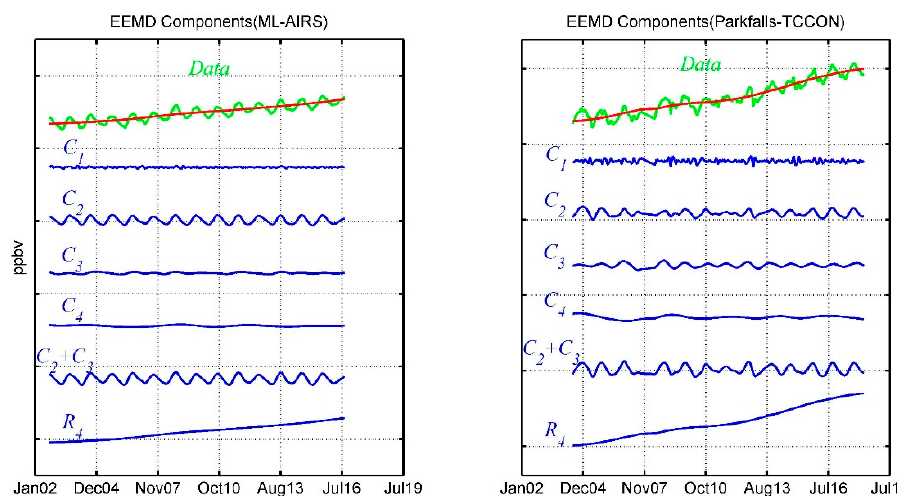
Figure 4. Same as Figure 3, however using AIRS CH 4 over the Mid-latitude region ( left ) and total column CH 4 (X ch4 ) from Parkfalls/TCCON site ( right ).